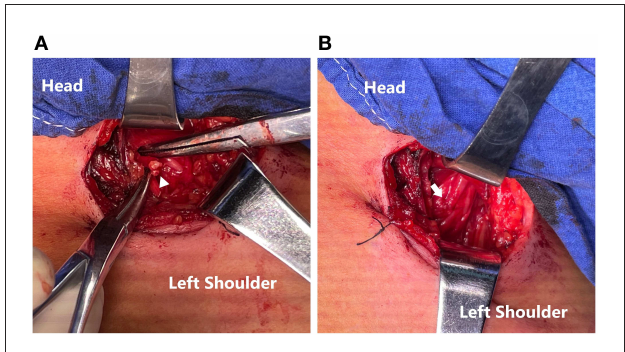
FIGURE2 (A) Ends of PDIC7 and C5 root (triangle). (B) Transfer of the PDIC7 to the C5 root (arrow).